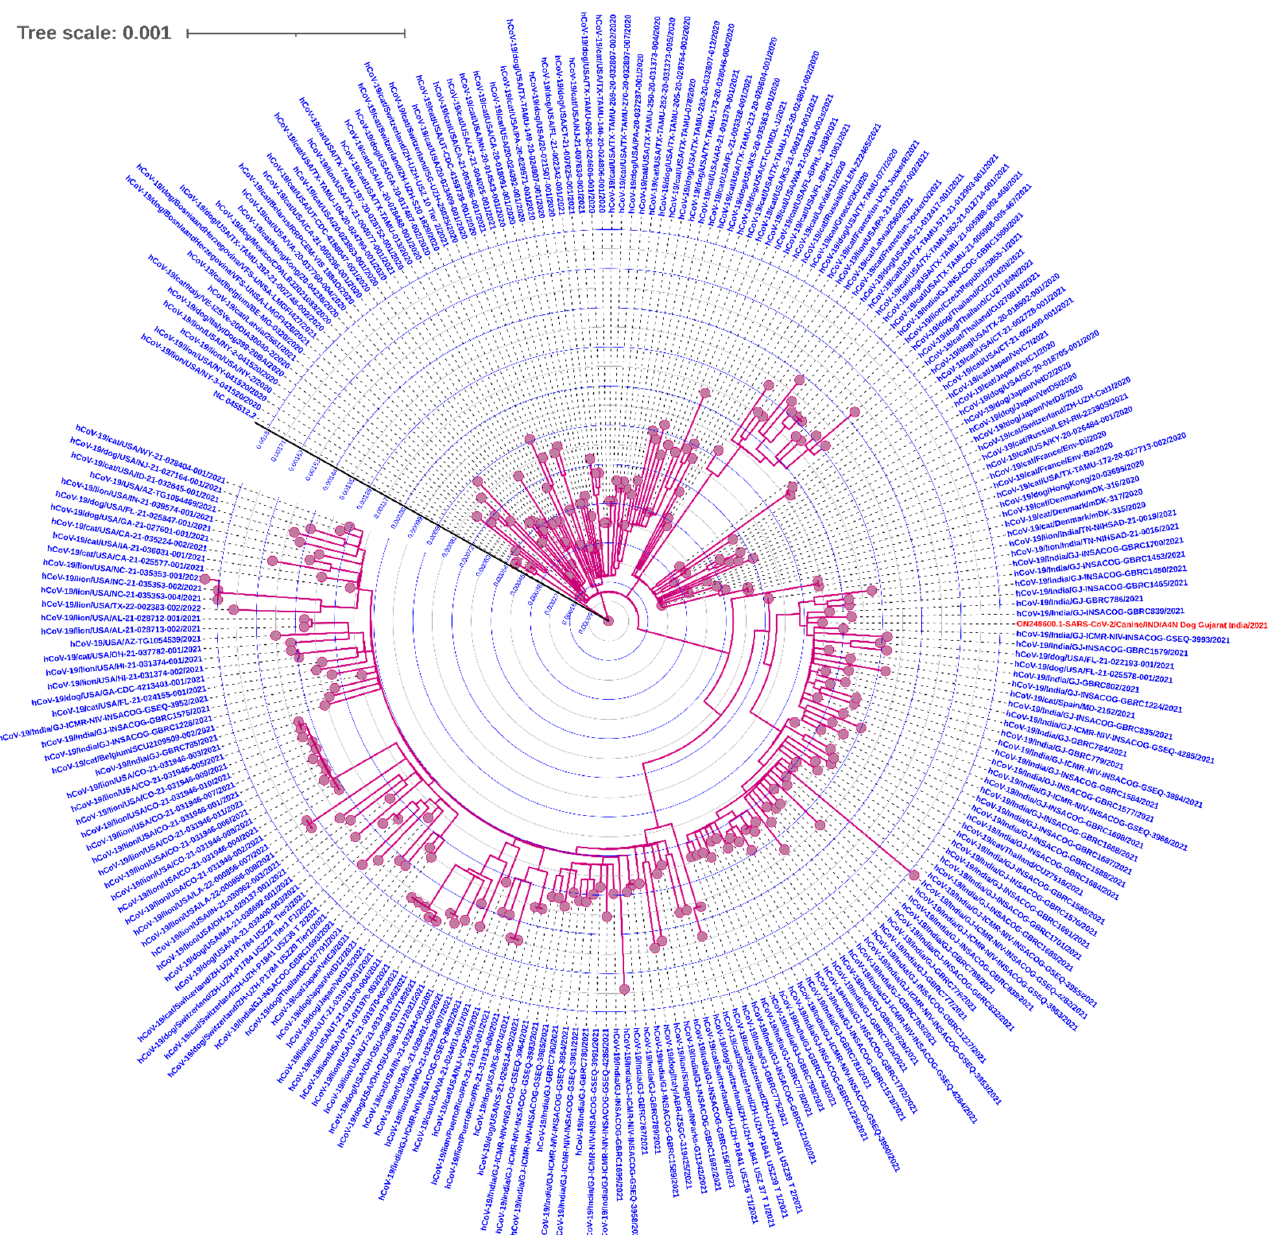
Figure 2. The phylogenetic placement of the A4N genome (orange) sequenced from a dog from Ahmedabad, Gujarat, India. The other genomes included were represented by Canis lupus familiaris (n= 50), human (n = 75), Felis catus (n = 81), and Panthera leo (n = 43), obtained from the GISAID webserver with the criteria of complete and high coverage, and additional metadata information is provided in Supplementary Table